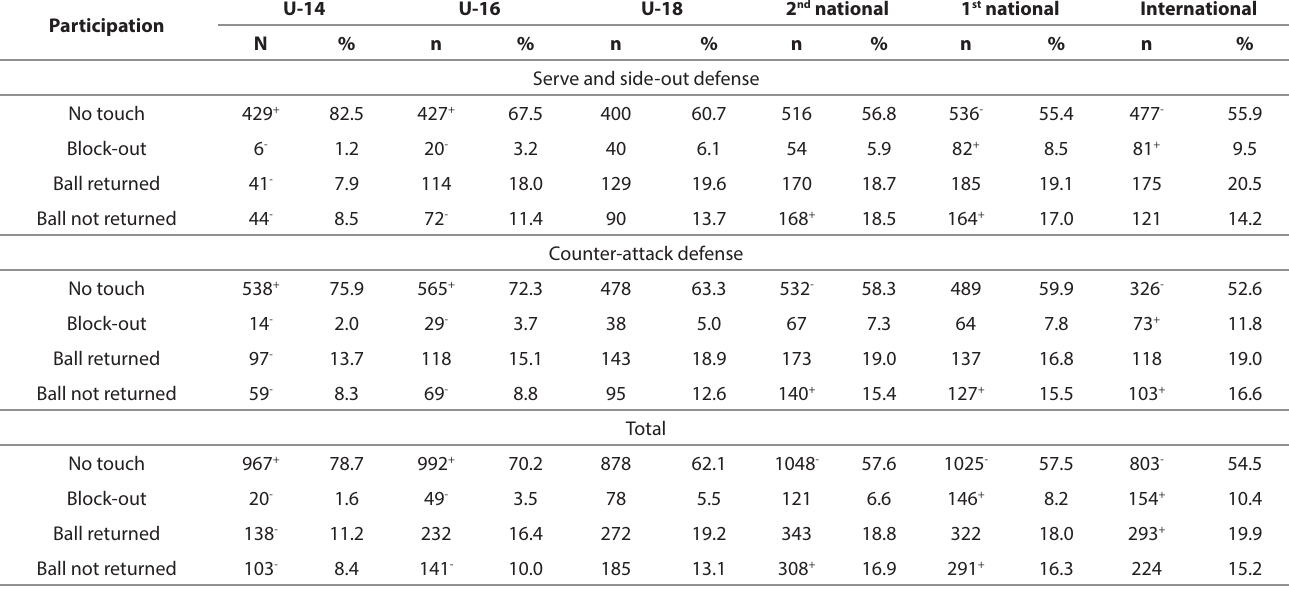
TABLE 4. Destination of the block according to game phase, timing of the attack and levels of competition (women’s volleyball)